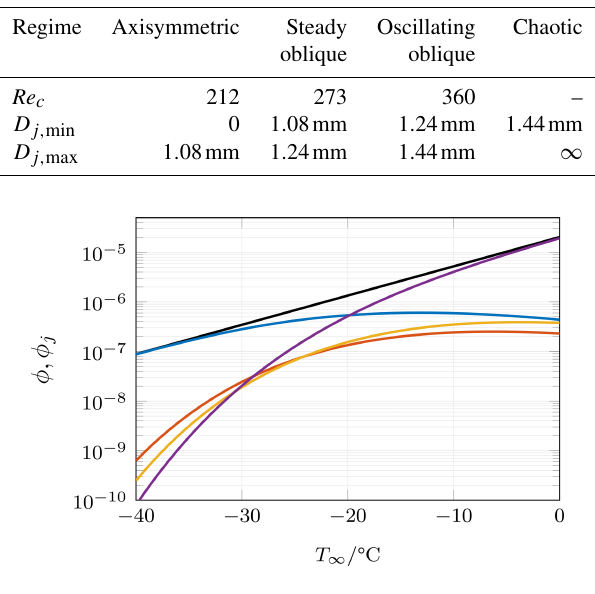
Figure 2. Volume fraction of ice particles in clouds as a func- tion of ambient temperature. The total volume fraction φ is dis- played by a solid black line, while the contribution by the regimes is given by the colored lines. Linestyles: axisymmetric regime (blue), steady oblique regime (red), oscillating oblique regime (yellow) and chaotic regime